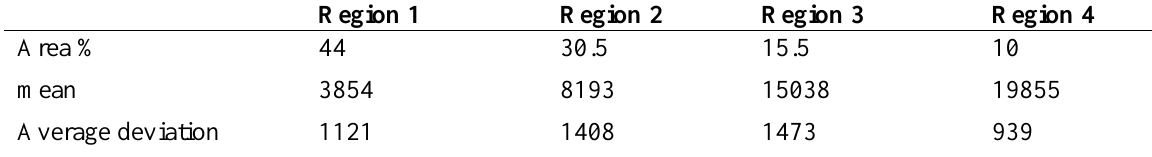
Table 4. The statistical characteristics of wind power with 15 m rotor radius Region 1 Region 2 Region 3 Region 4 Area % 44 30.5 15.5 10 mean 3854 8193 15038 19855 Average deviation 1121 1408 1473